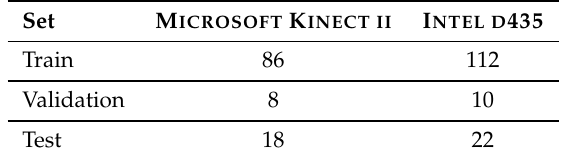
Table 4. Train, validation, and test splits for depth integration in object